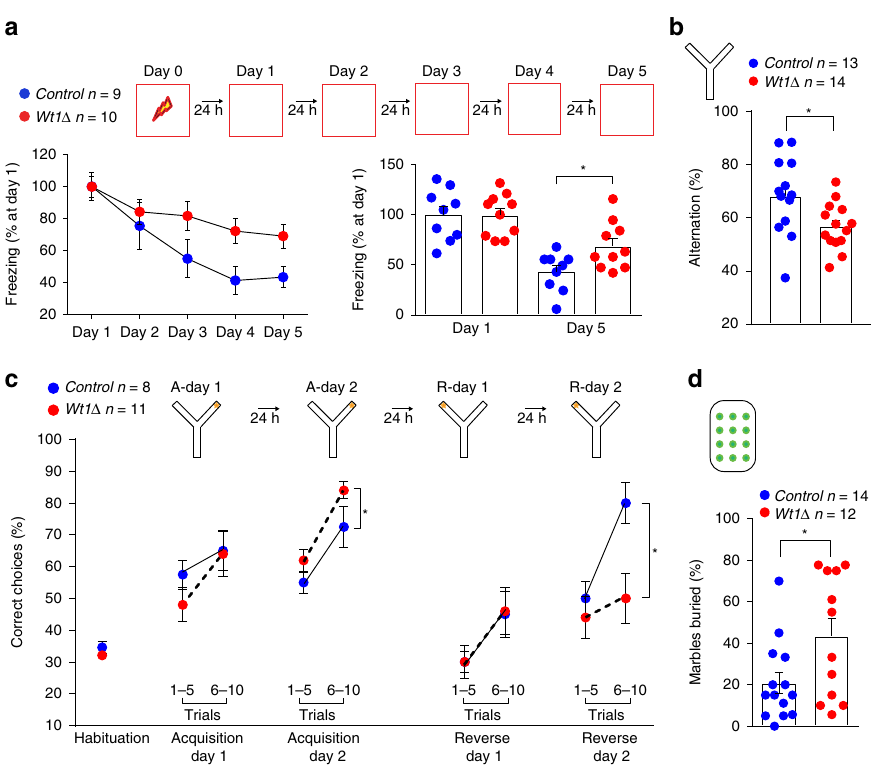
Fig. 6 WT1 controls memory fl exibility. a Wt1 Δ mice exhibited a lower rate of fear extinction than their control littermates measured at day 5 of extinction; % freezing at day 5 was normalized to freezing at day 1 (unpaired t test: * p = 0.0196). b Wt1 Δ mice showed impaired spontaneous alternation